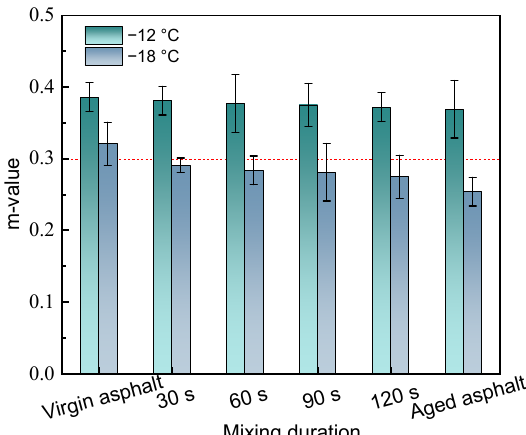
Figure 10. Variation in asphalt creep rate m with different mixing durations at different